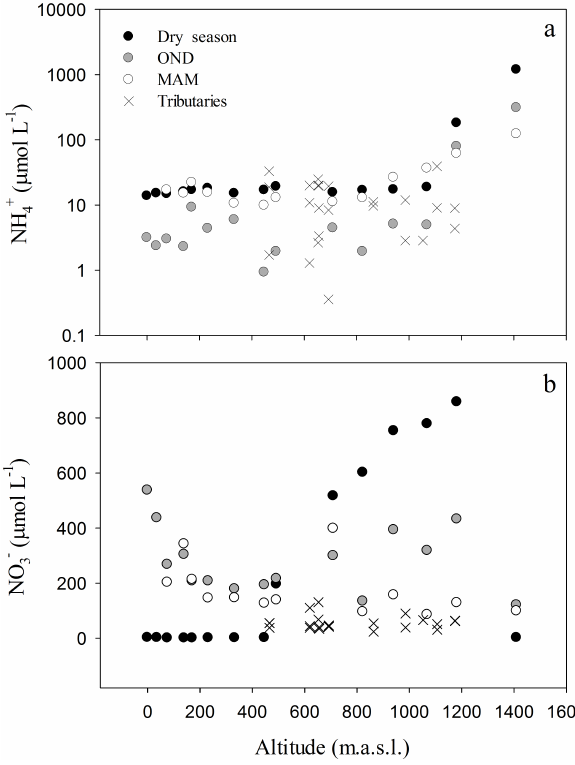
Fig. 4. Altitudinal gradient during dry season (August–September 2011), short rain season (October–December, OND, November 2011) and long rain season (March–May, MAM, April 2012) and tributaries (x, all seasons) of in-stream (a) NH + (b) NO − (µmol L − 1 ) . Note the logarithmic scale on the top panel. 3